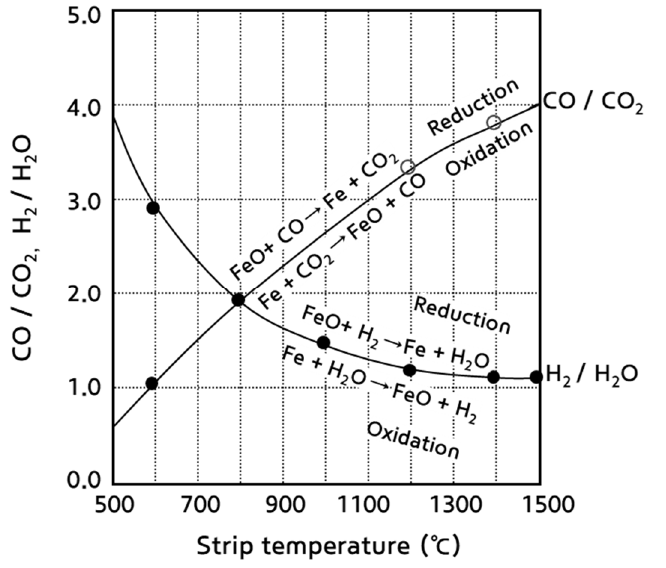
Figure 8. Oxidation and reduction of steel with the concentration of gases and surface temperature [18]. ture